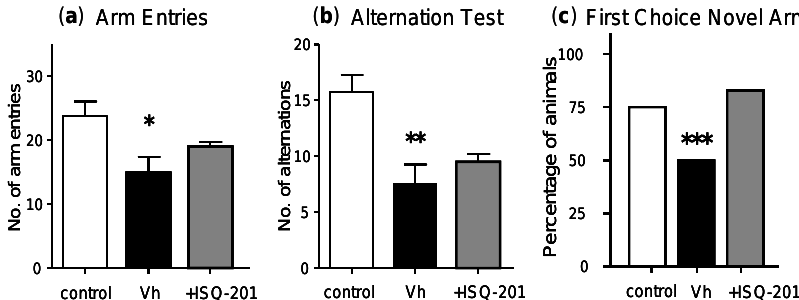
Figure 6. Behavioral tests after cerebral ischemia at long-term. The bar graphs represent the results obtained after three spatial recognition and spatial memory test, to assess the long-term cognitive impairment of control animals and vehicle (Vh)- and the ISQ-201-treated ischemic animals, at 11 weeks after ischemic reperfusion. The values represent the mean of 6 independent tests, performed on different animals. In ( a ) and ( b ), error bars indicate the SE, * p < 0.05 and ** p < 0.01, as compared to the control group using Dunn’s post-test after Kruskal−Wallis test; in ( c ), *** p < 0.001, and as compared to the vehicle using Fisher's test.